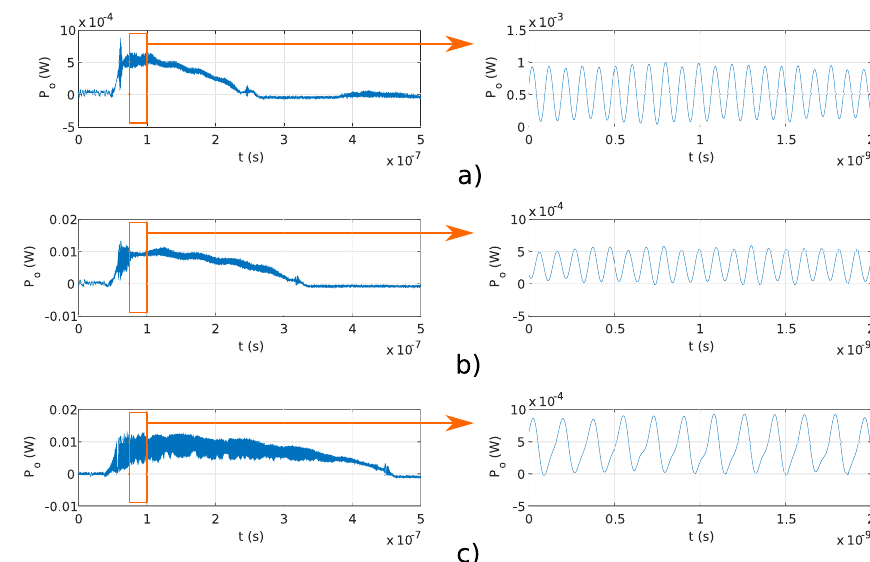
Figure 10. Pulses and fringes obtained using Fabry–Perot fiber interferometer with OPD ∆ L = 0.16 m